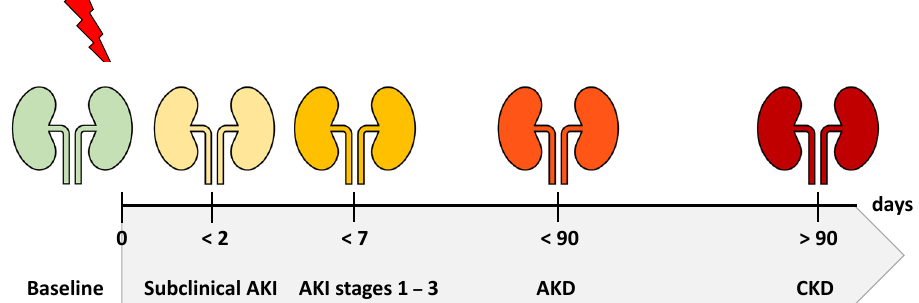
Figure 1. The spectrum of disease: AKI (acute kidney injury), AKD (acute kidney disease), CKD (chronic kidney disease).